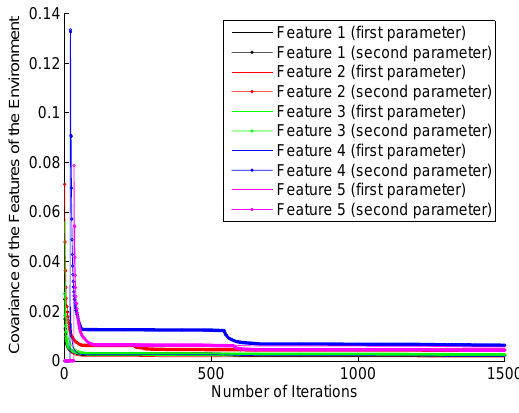
Figure 16. Covariance evolution of a same set of features of Figure 12 estimated by EKF-SLAM with the maximum eigenvalue feature selection approach.